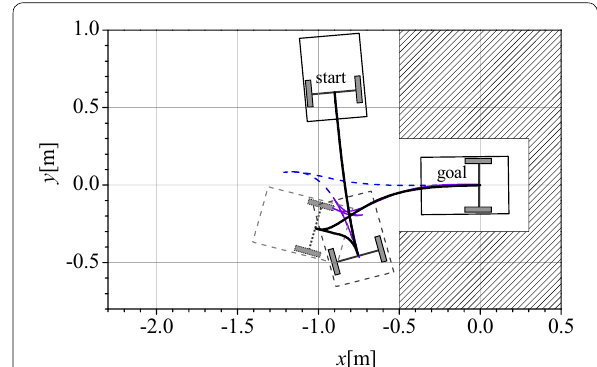
Fig. 17 Results of the experiment with the parameters searched by the genetic